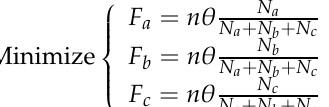
Figure 2. Using Support Vector Machine (SVM) to divide the vaccine data-base into three regions. The second step is to count the number of historical GMPP in Region a, Region b, and Region c, and set them as N a , N b , N c respectively. So, the initial distribution of population in Region a, Region b, and Region c can be calculated by Formula